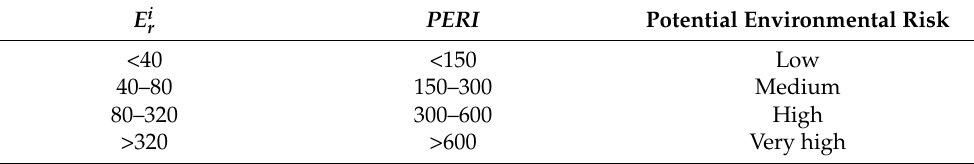
Table 7. Interpretation of the potential environmental risk indicator (PERI) value